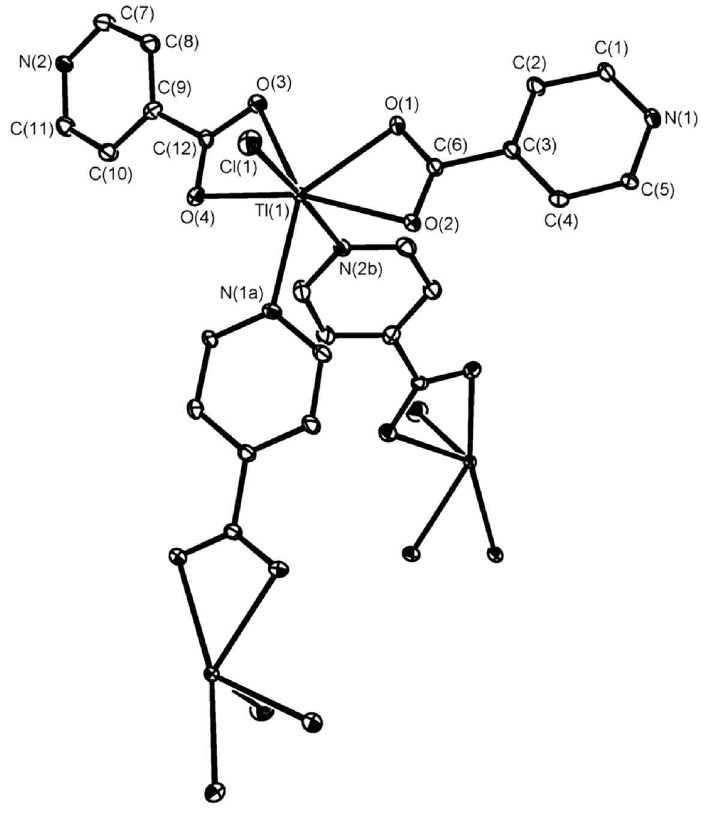
Fig. 4 A fragment of the three-dimensional network in [TlCl(inic) 2 ] ¢ 0.6 C 2 H 5 OH ( 3 ). The atoms are drawn with 30% probability